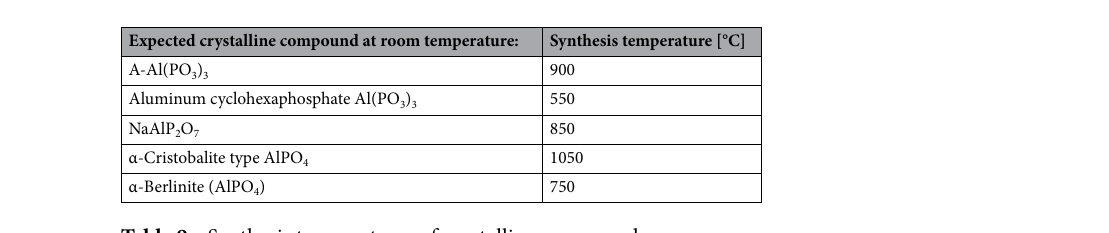
Table 9. Synthesis temperatures of crystalline compounds.